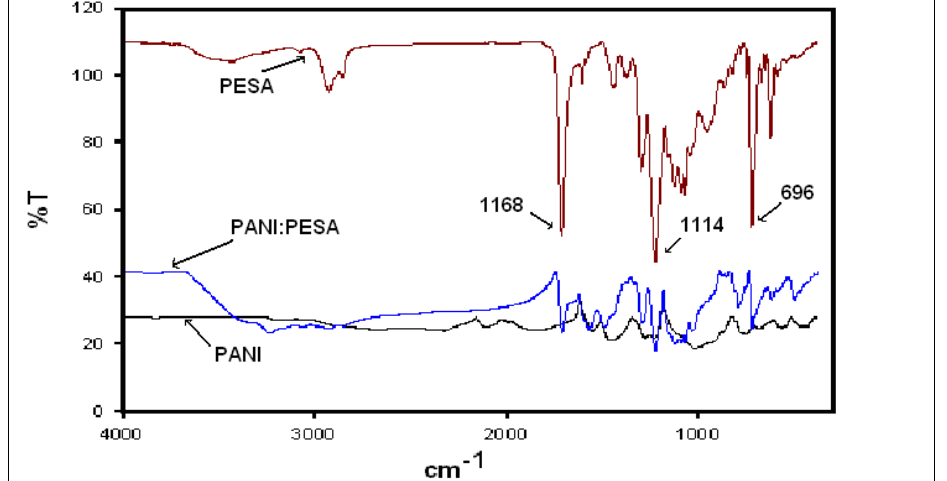
Figure 4. FTIR spectra of PESA, PANI and